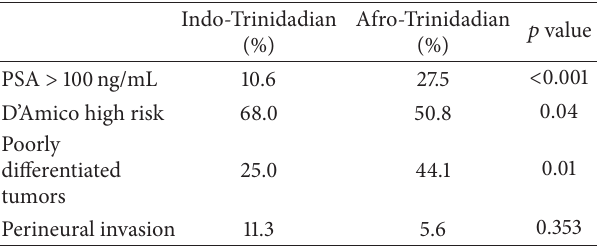
Table 3: Racial disparities in clinicopathologic features within the